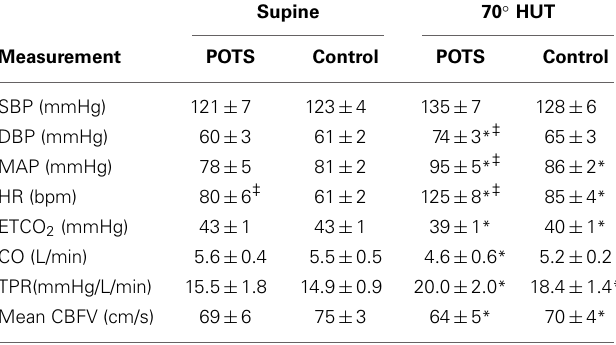
Table 1 | Hemodynamic parameters measured supine and upright in control subjects and in patients with Postural Tachycardia Syndrome (POTS).